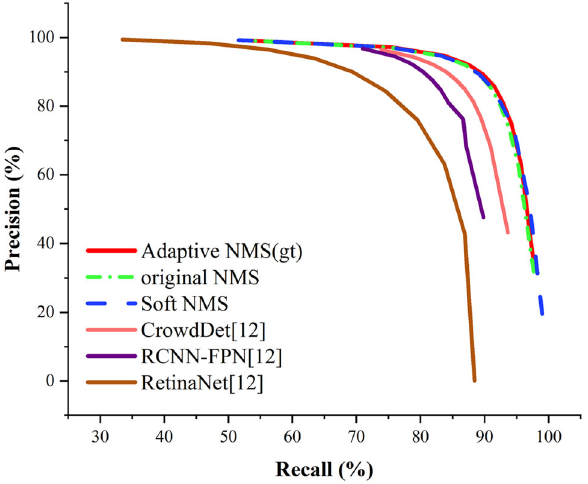
Fig. 6 PR curve comparison with SOTA